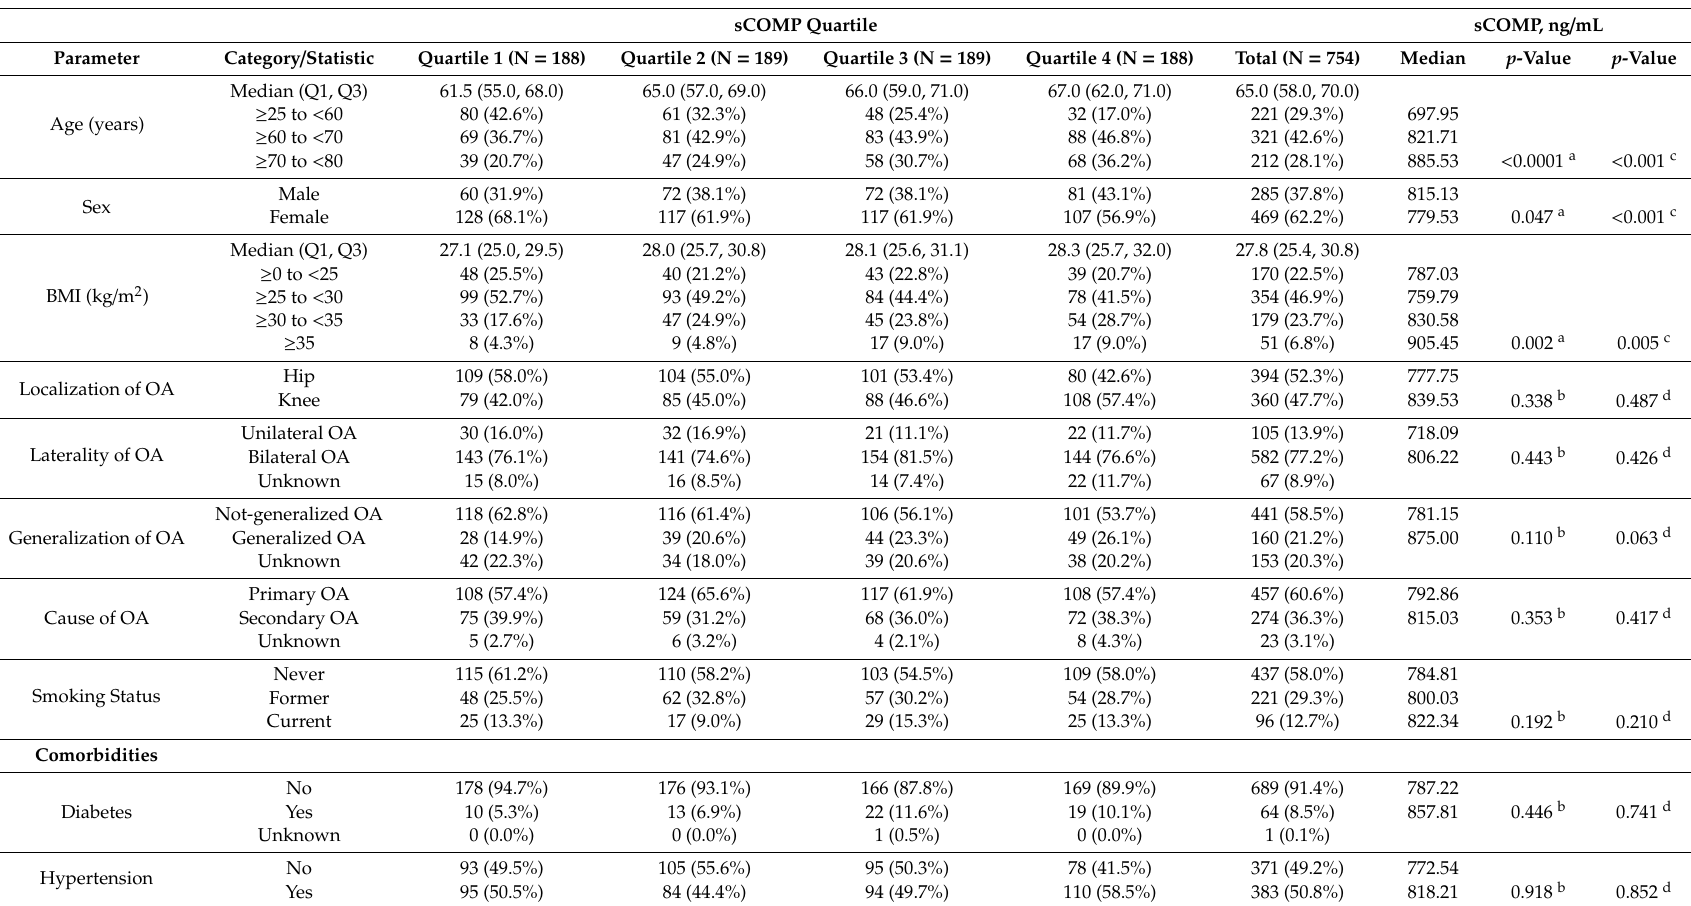
Table 2. sCOMP levels in relation to the characteristics of patients with osteoarthritis (OA)